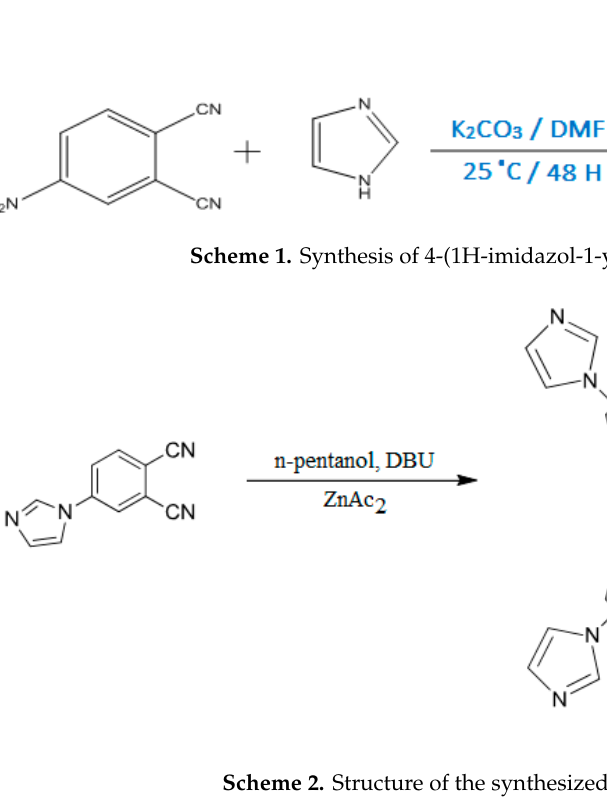
Scheme 2. Structure of the synthesized compounds.